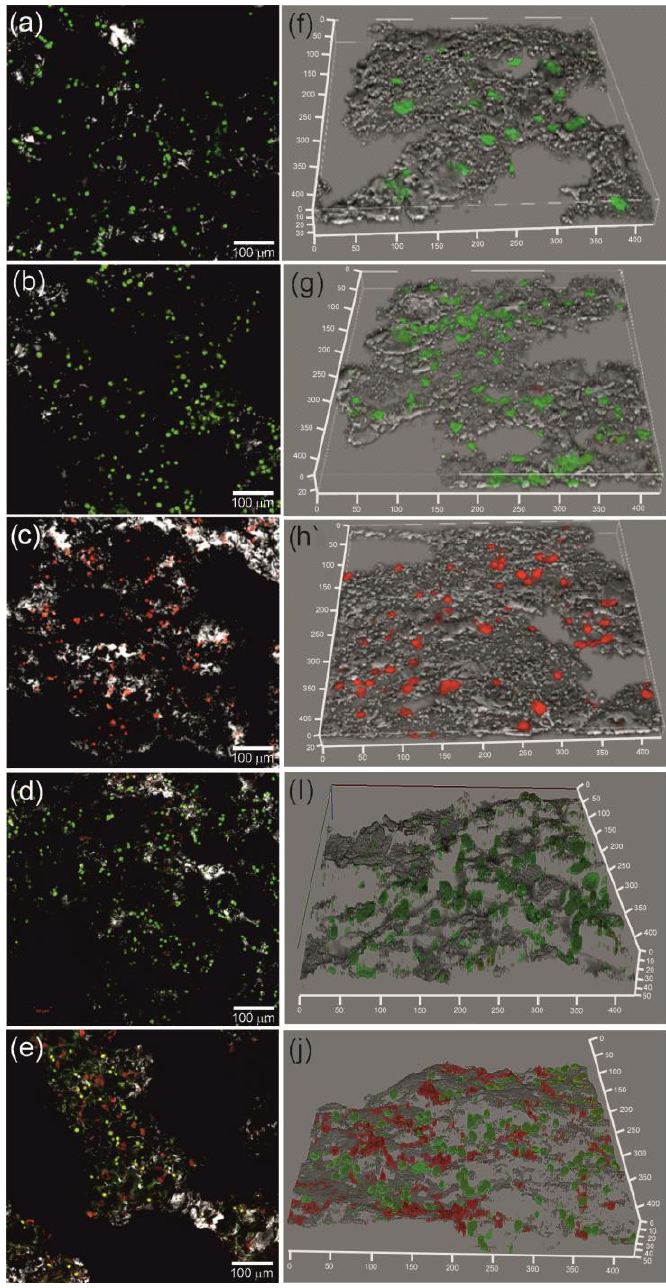
Figure 8. Confocal laser scanning microscopy of porous samples after 24-h culturing with MCF-7 cells: control sample ( a , f ), vacuum modification method ( b , g ), without external effects ( c , h ), microwave modification method ( d , i ), ultrasonic modification method ( e , j ).